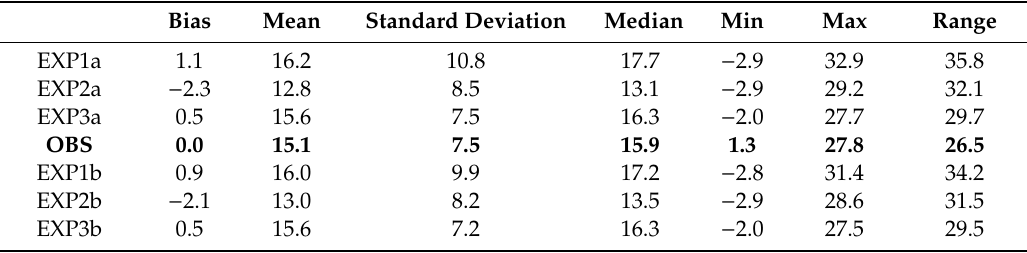
Table 9. Soil temperature (TS) ( ◦ C) (0–10 cm) simulated and observed at the CO station (data number